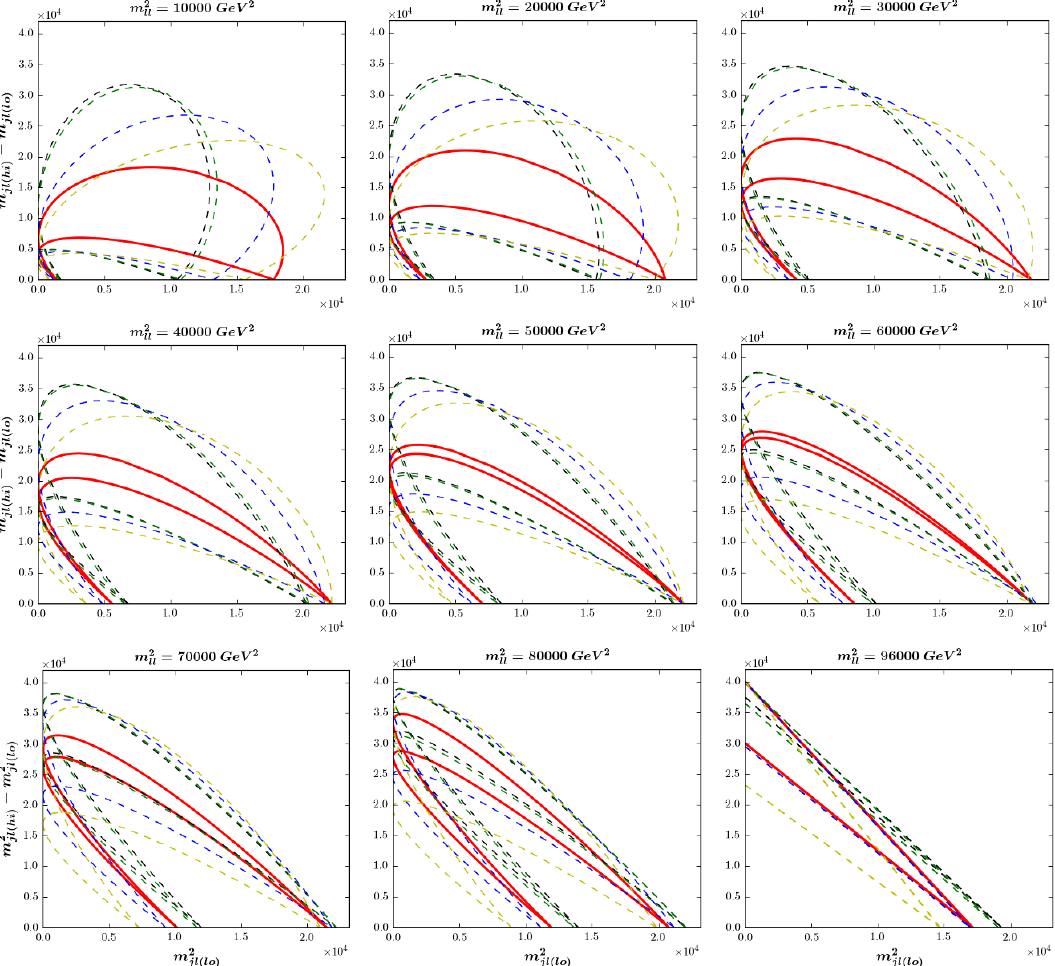
Figure 22 . The same as (cid:12)gure 21, but for the auxiliary branch in regions (4 ; 2), (4 ; 3) and (2 ; 3). The dashed lines represent points with ~ m A = 90 GeV (black), ~ m A = 150 GeV (green), ~ m A = 500 GeV (blue) and ~ m A = 5000 GeV (yellow). For reference, we also show the case of the true mass spectrum for point P 32 (red solid lines), although P 32 itself does not belong to the auxiliary